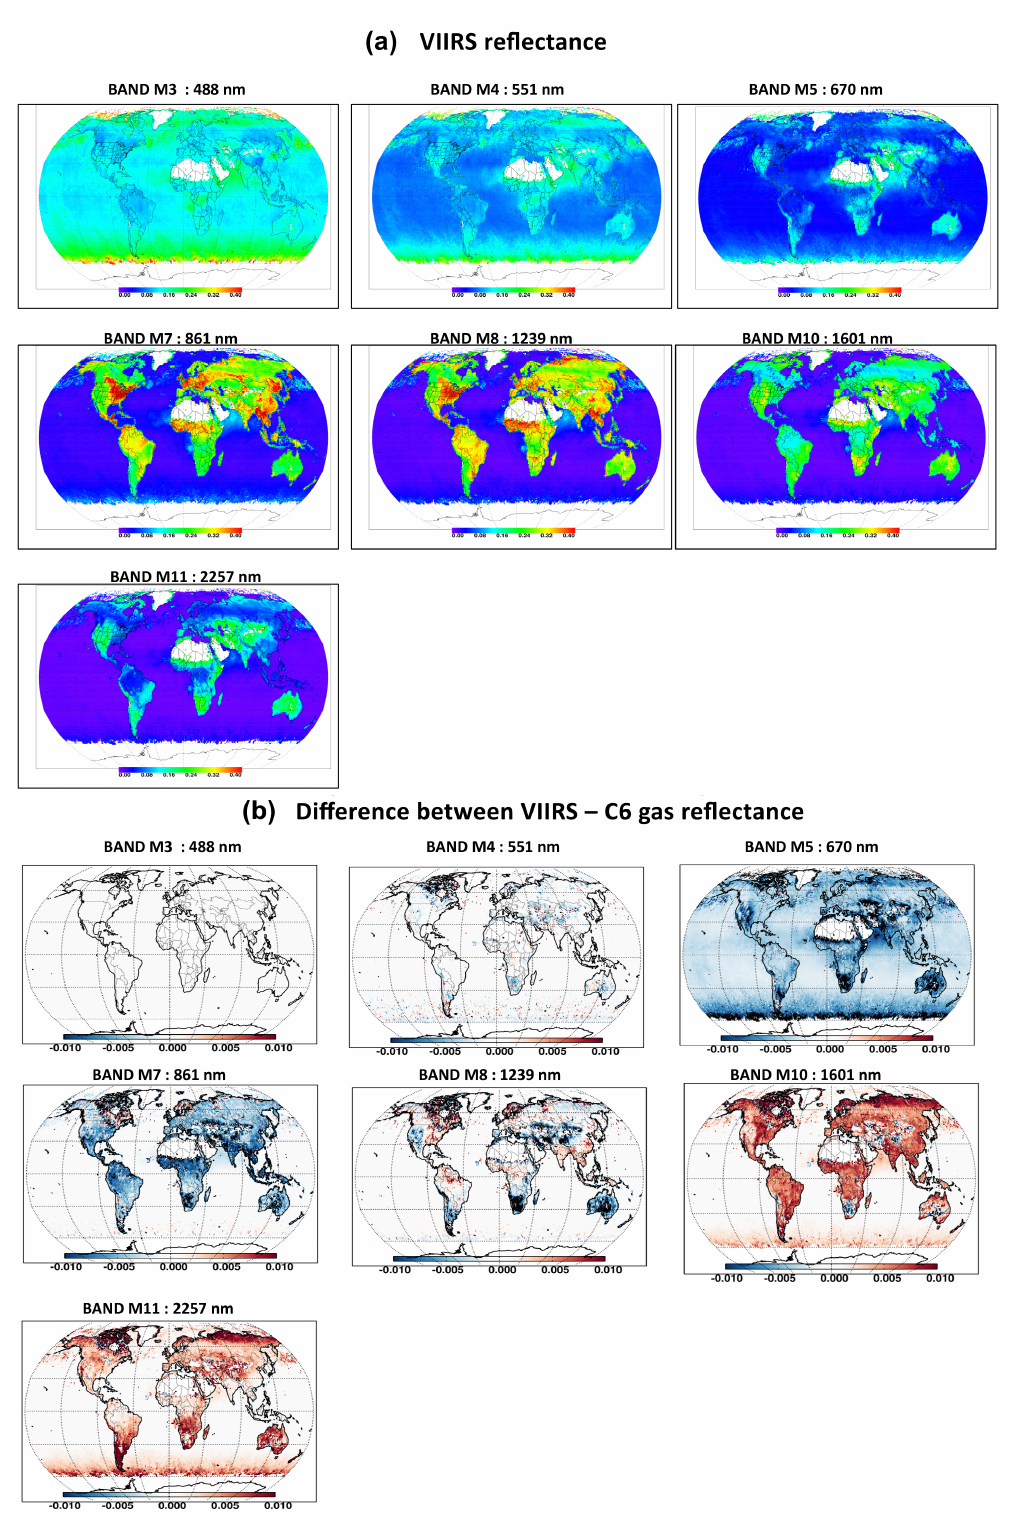
Figure 6. (a) shows the spatial distribution of gridded L2 reflectance in seven VIIRS channels (i.e., M3, M4, M5, M7, M8, M10, M11) for July 2013. (b) shows the spatial distribution of the difference between VIIRS reflectance obtained by applying VIIRS gas correction coefficients and MODIS C6 gas correction coefficients in seven VIIRS channels (i.e., M3, M4, M5, M7, M8., M10, M11) for July 2013. This panel demonstrates the impact of using MODIS gas correction on VIIRS reflectance used for retrieving aerosol optical